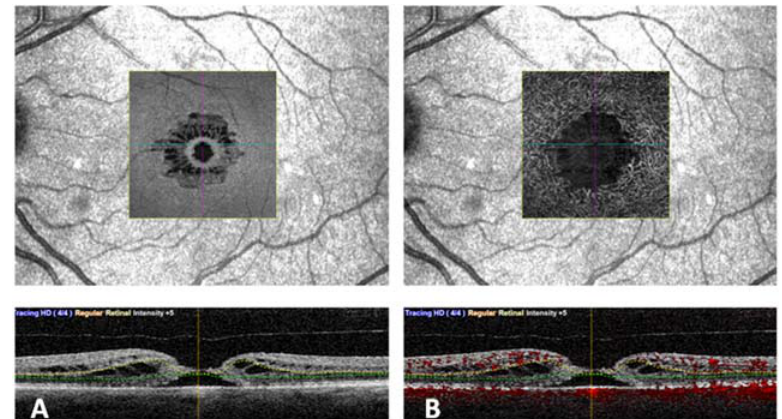
Figure 1. An eye with full thickness macular hole analyzed using en face optical coherence tomography (OCT) ( A ) and OCT angiography ( B ). In the lower part the corresponding segmentation is visible. The default RS-3000 Advance 2 OCTA AngioScan software was used to evaluate the vessel density (VD) (ETDRS-based vessel density [%]) of the SCP and DCP. Vascular density was defined as the percentage of the total area occupied by vessels. Vessel densities of the SCP and DCP were automatically calculated by the software on OCTA 3 × 3-mm volume scans in the whole foveal and the inner and outer retina (Figure